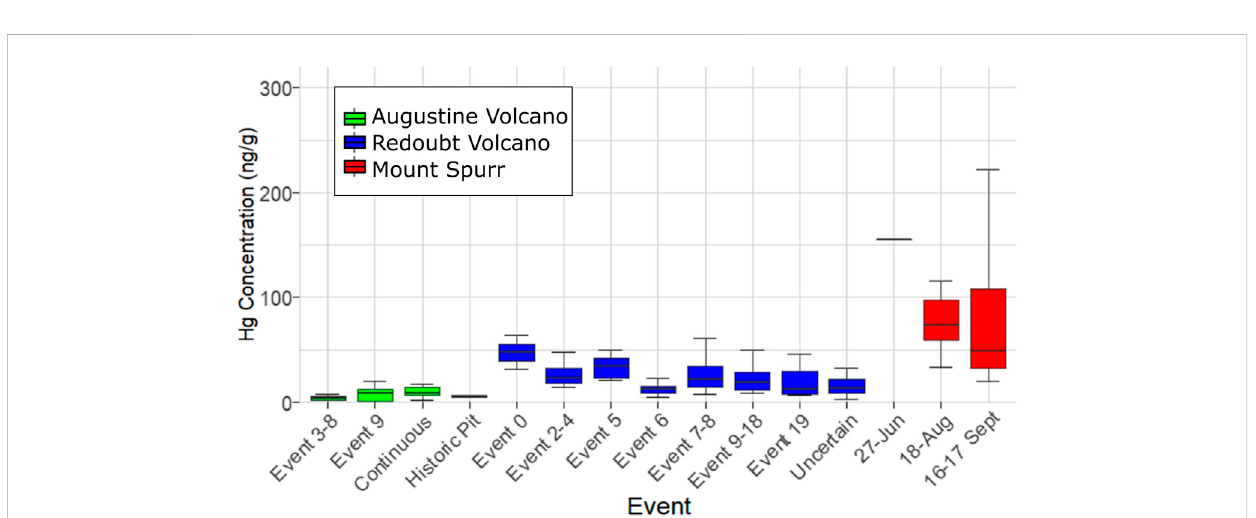
FIGURE 3 Box plot of sample Hg concentration measured as PBM on volcanic ash for individual events within Augustine Volcano (green), Redoubt Volcano (blue), and Mount Spurr (red) eruptions showing median Hg concentration (thick lines), interquartile ranges (colored boxes), and minimum/maximum values excluding outliers (horizontal